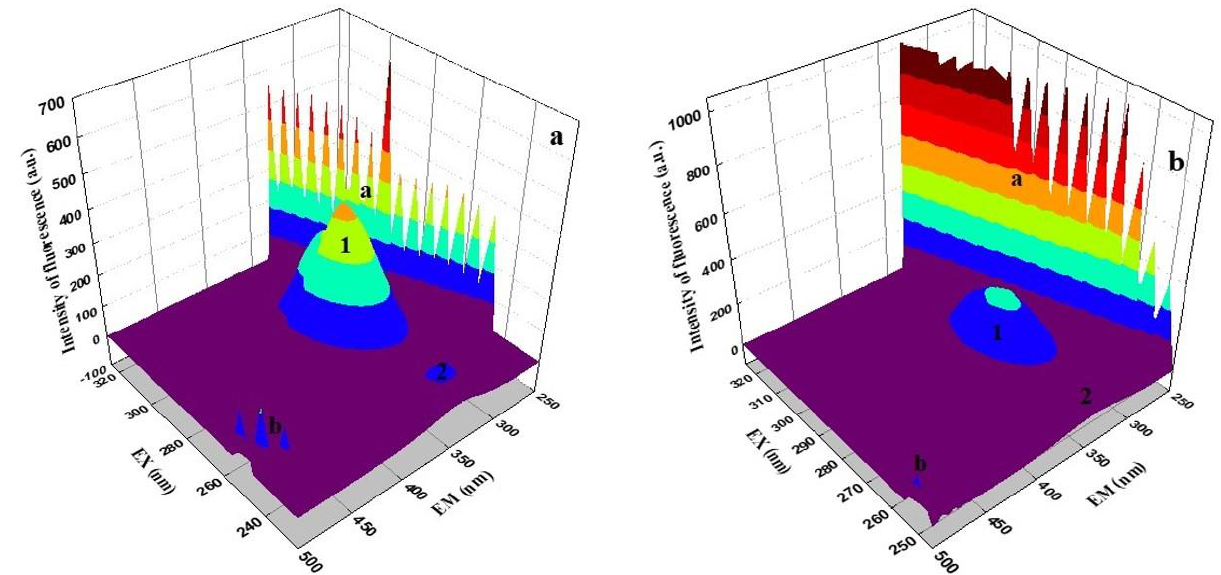
Figure 9. 3D fluorescence spectra of bovine serum albumin (BSA) ( a ) and prothioconazole/bovine serum albumin (PTC/BSA) 16/1 ( b ) complex.